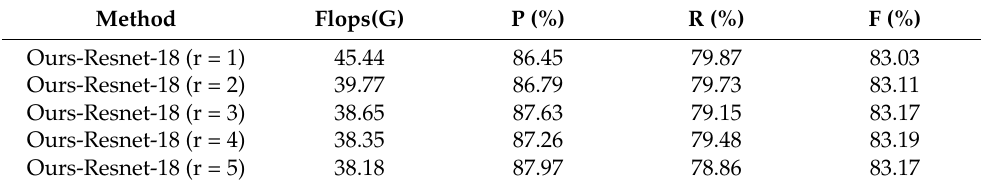
Table 5. Ablation experiment of sampling factor